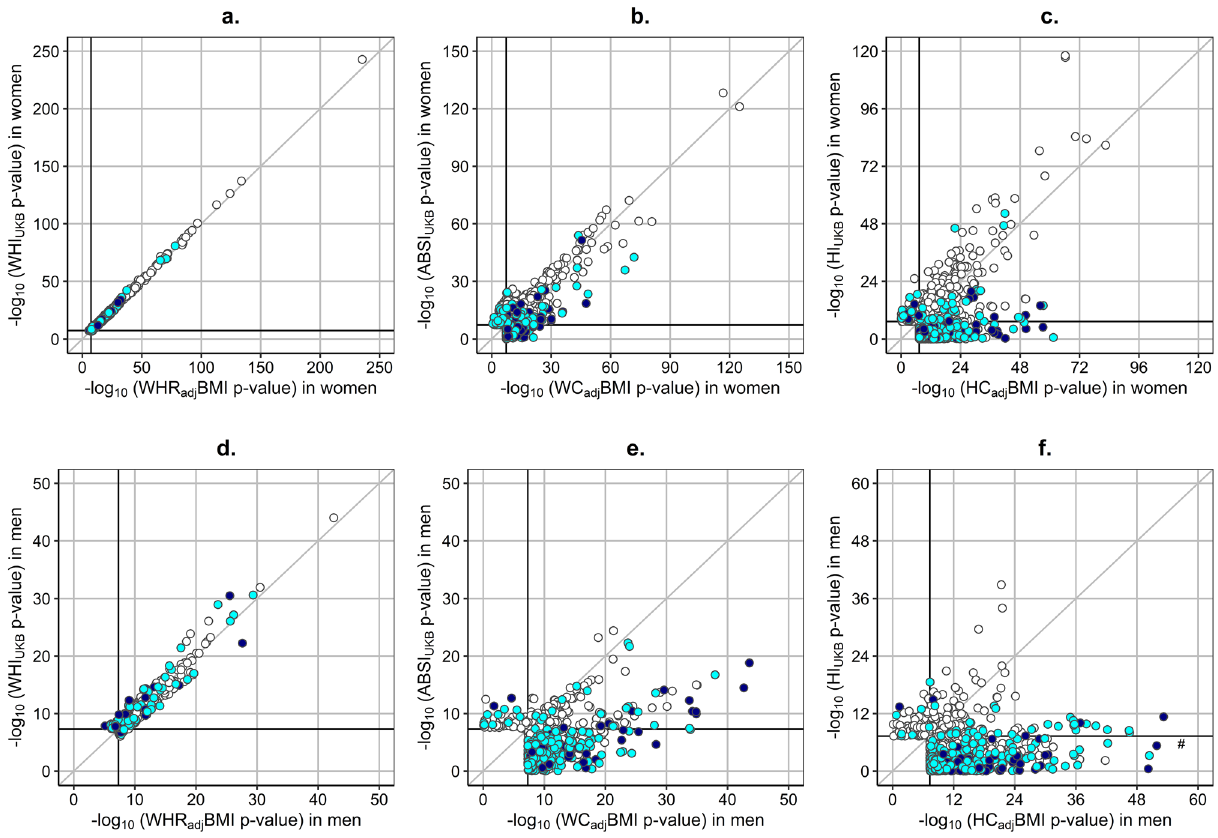
Figure 6. Significance ranking of independent significant SNPs: comparison between pairs of traditional and allometric body-shape indices. ( a ) independent significant SNPs (at r 2 < 0.6 within 1 Mb window) for WHI UKB (n = 1,988) or WHR adj BMI (n = 1,959) in women; ( b ) independent significant SNPs for ABSI UKB (n = 1,273) or WC adj BMI (n = 1,586) in women; ( c ) independent significant SNPs for HI UKB (n = 814) or HC adj BMI (n = 2,008) in women; ( d ) independent significant SNPs for WHI UKB (n = 617) or WHR adj BMI (n = 571) in men; ( e ) independent significant SNPs for ABSI UKB (n = 266) or WC adj BMI (n = 842) in men; ( f ) independent significant SNPs for HI UKB (n = 222) or HC adj BMI (1,400) in men. Association statistics p-values were derived from BOLT-LMM infinitesimal models. ABSI UKB -a body shape index calibrated for UK Biobank participants; BMI-body mass index; HC adj BMI-hip circumference adjusted for BMI; HI UKB -hip index calibrated for UK Biobank participants; SNP-single nucleotide polymorphism; WC adj BMI-waist circumference adjusted for BMI; WHR adj BMI-waist-to-hip ratio adjusted for BMI; WHI UKB -waist-to-hip index calibrated for UK Biobank participants. Colour scale-colour-marked were only SNPs reported as associated with height in the NHGRI-EBI GWAS Catalog 11 (https:// www. ebi. ac. uk/ gwas/ home, accessed on 07/04/2021), i.e. included in catalogue sets EFO_0004339 or EFO_0004302; (navy circle)-independent significant SNP reported in association with height; (cyan circle)-independent significant SNP in strong LD (at r 2 ≥ 0.6) with a SNP reported in association with